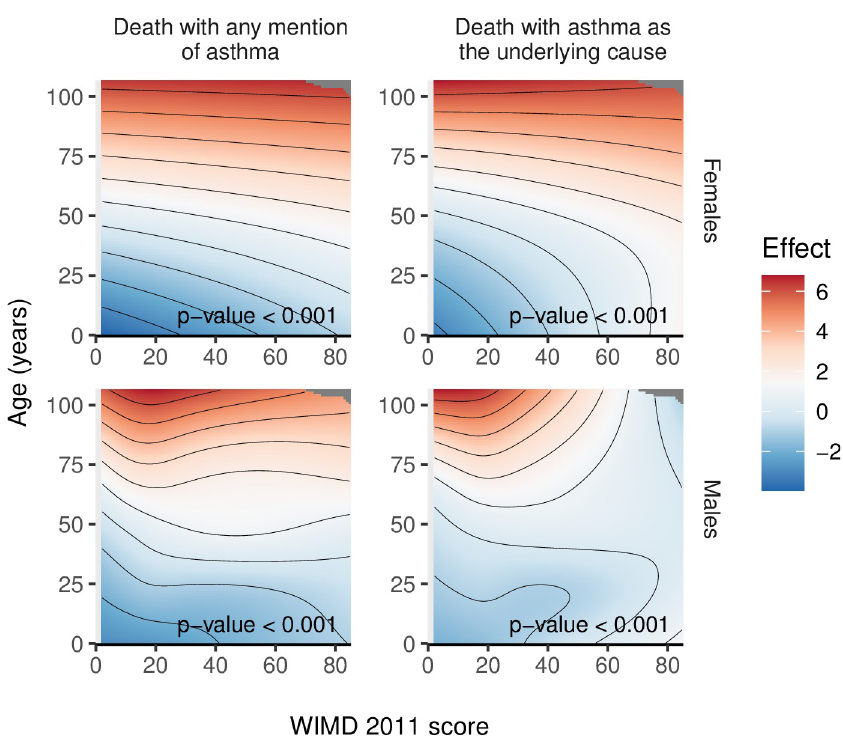
Fig 13. Full tensor product smooths from GAMs of asthma deaths by the WIMD 2011 score and age in males and females. The colour represents the partial effect (blue = lower, red = higher). The models did not include separate smooths for the WIMD 2011 score and age. Generally, higher deprivation and older age were associated with higher risk of asthma deaths. However, in males over the age of 75 years, lower deprivation was associated with higher risk. GAM, generalised additive model; WIMD, Welsh Index of Multiple